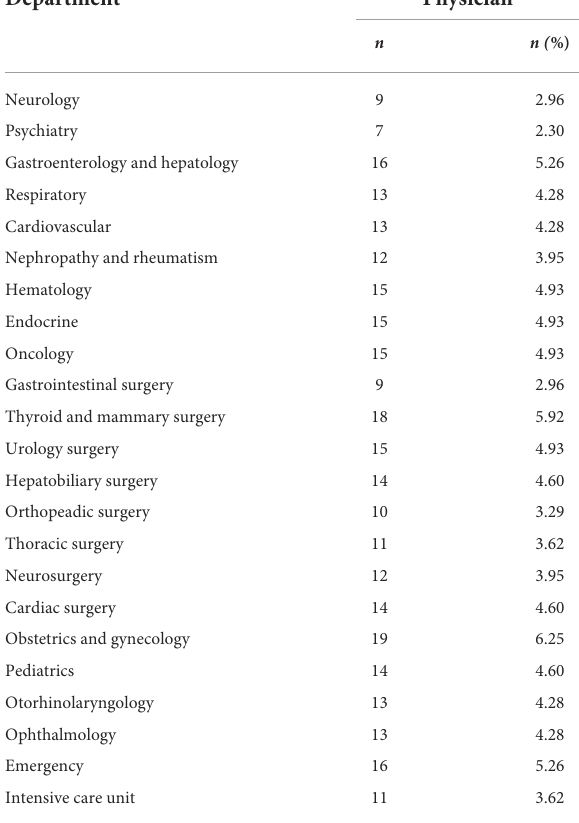
TABLE 2 The department distribution of